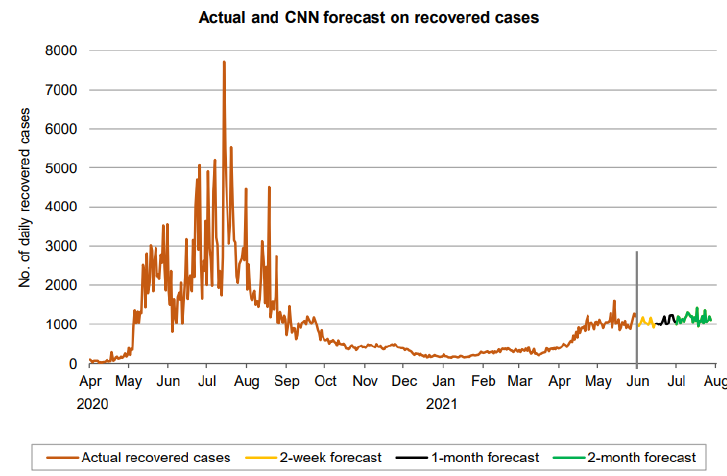
Figure 18. Prediction over a 60-day forecast for the recovered cases using the CNN model.